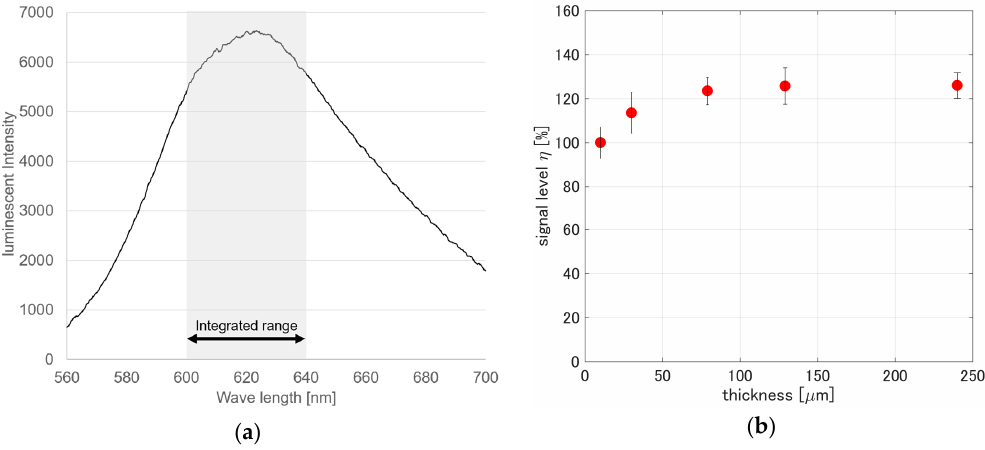
Figure 5. ( a ) Luminescent spectrum of PCPSP th 01 at the reference conditions; ( b ) Signal level related to PC- PSP thickness.